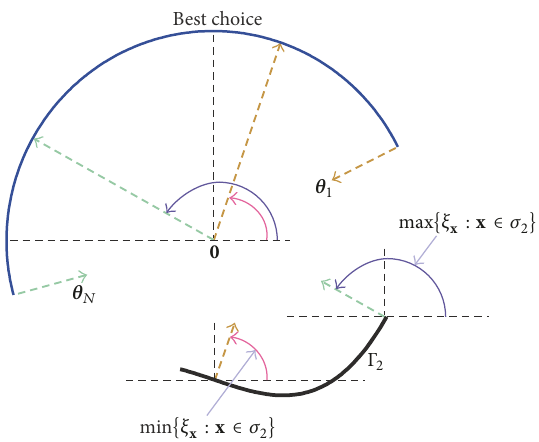
Figure 5: Description of best choice of the range of incident